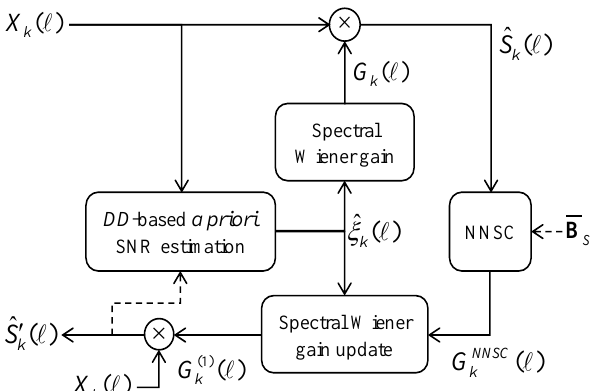
Figure 4. The block diagram of the proposed spectral gain enhancement driven by non-negative sparse coding (NNSC)-based residual noise